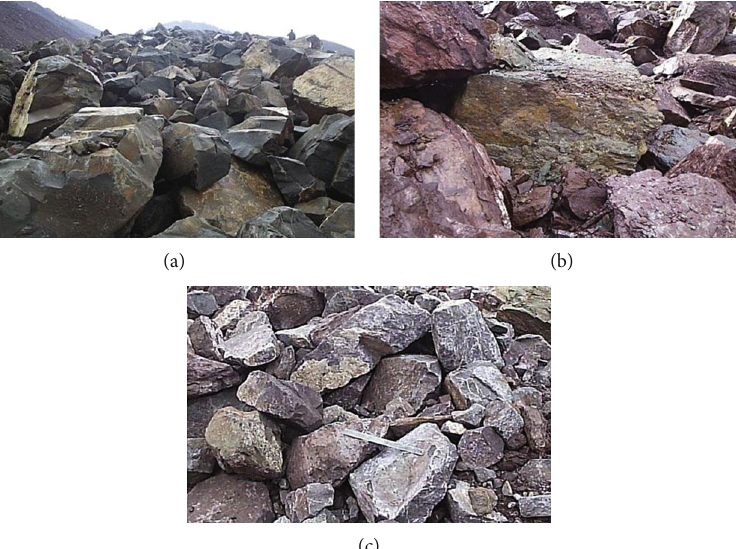
Figure 19: Examples of coarse materials from Hattian Bala landslide dam: (a) grey sandstone; (b) purple to reddish-brown mudstone (shale); (c) sandstone (used as a scale is a 12 ″ stainless steel ruler). Table 4: D / D ratios for samples of the matrix material from the Hattian Bala landslide dam separated at selected particle sizes. 15 85 Sample